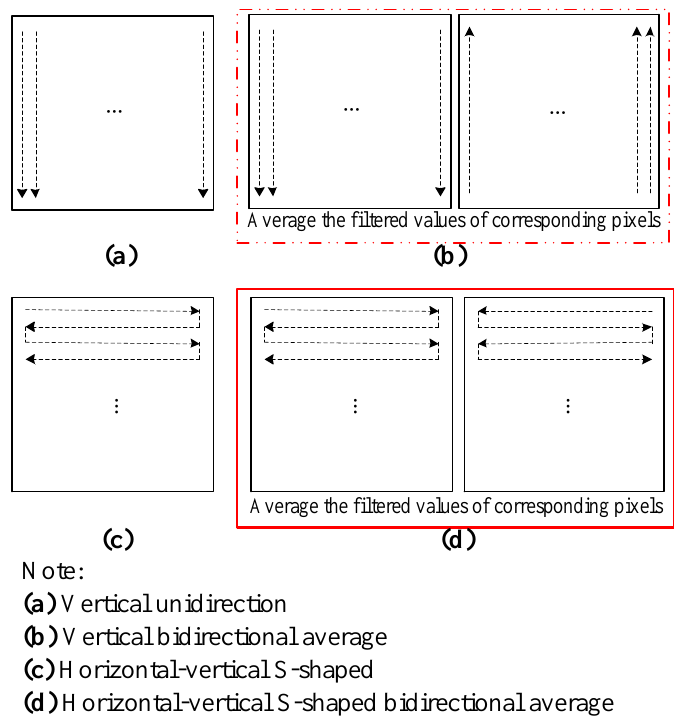
Figure 3. Schematic diagram of calculation scanning mode.